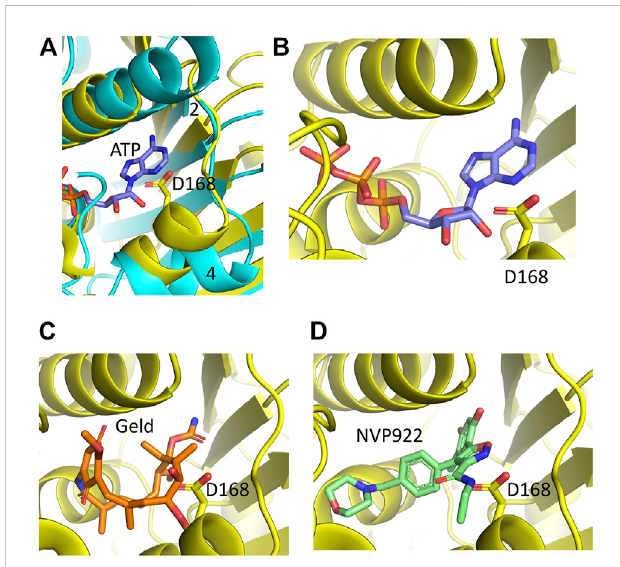
FIGURE 7 PyMol cartoons of Hsp90 N-terminal domain inhibitors superimposed into sacsins ATP binding pocket. (A) α -Helix 4 of Hsp90 (cyan) is positioned to create a more open ATP-binding site. In contrast, the equivalent α -helix in sacsin (yellow) restricts the opening of the ATP-binding pocket. Strand 2, β -strand 2 of Hsp90 is indicated. (B) ATP docked into the ATP-binding site of sacsin, showing that it avoids any obvious clashes with the side chain of Asp 168. (C) Geldanamycin docked into the ATP-binding site of sacsin, showing that it clashes with the side chain of Asp 168. (D) AUY922 docked into the ATP-binding site of sacsin, showing that it clashes with the side chain of Asp 168.